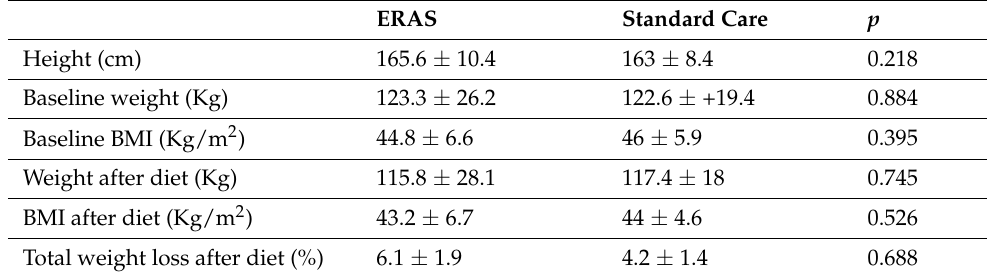
Table 3. Baseline anthropometric measurements and weight loss obtained with the balanced preoper- ative diet 3 months before surgery. (Student’s t